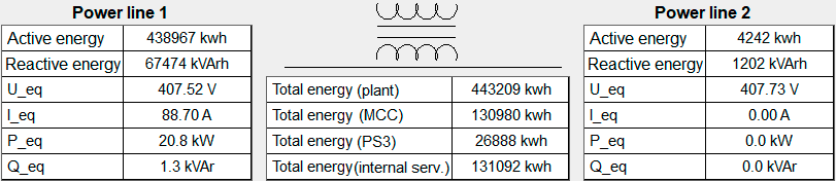
Figure 3. Main electrical parameters monitoring of the WTP and water distribution facility (WDF).